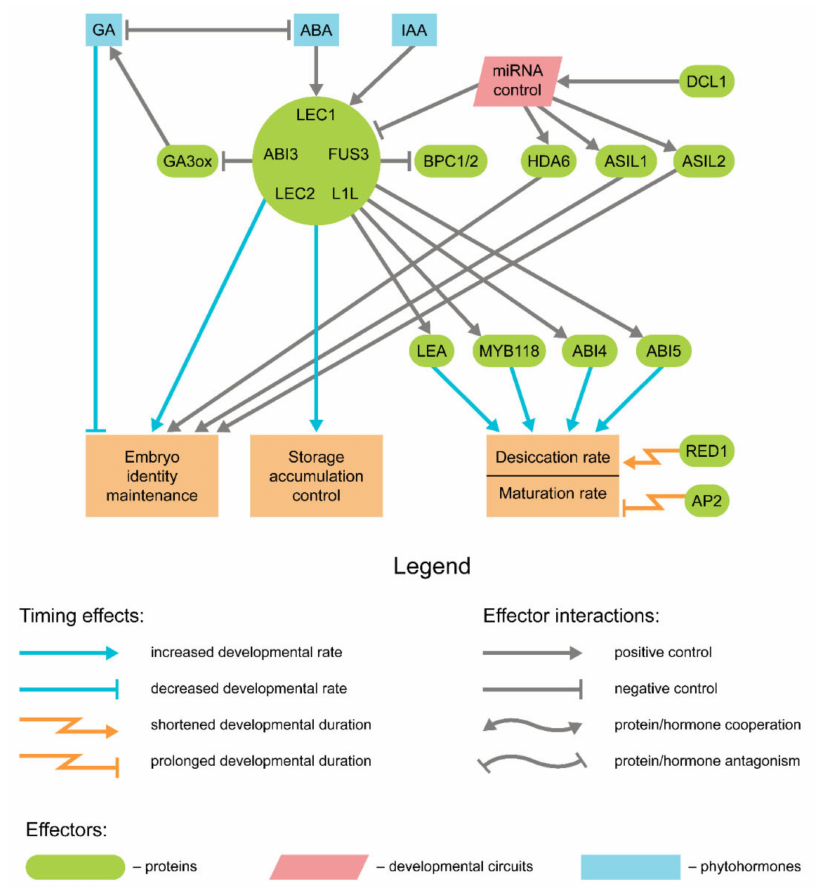
Figure 3. Key processes governed by LAFL factors in respect of maturation duration. The downstream component of LAFL signaling may also affect the seed development rate. Ohto and colleagues [100] demonstrated that the duration of seed filling is longer in ap2 mutants of Arabidopsis as compared to the wild type. AP2 encodes a transcription regulator mostly associated with endosperm size control in seeds (see below); thus, pro- longed seed filling duration may indicate both an indirect influence of endosperm growth on later embryo development or versatility of AP2 functions in Arabidopsis seeds. This prolongation is positively correlated with both the seed size and the cotyledon storage content [101,102]. Overexpression of another LAFL-governed gene, AtMYB118 , leads to the premature desiccation of seeds residing at the distal fruit end [103]. Delayed desiccation and decreased seed tolerance to desiccation-associated stress were reported for Arabidopsis mutants affected in the RED1 gene, although the functions of the respective protein